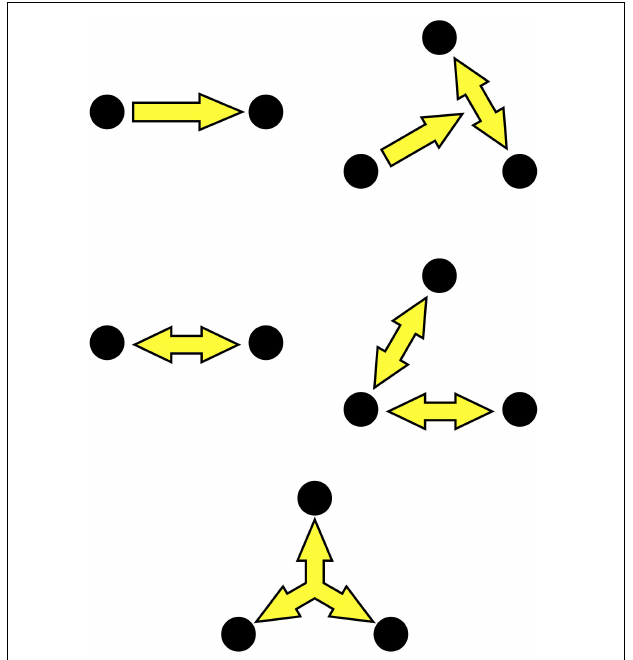
FIGURE 1 | Three hypothesized levels of SMCs in social interaction: (Top) Check SMCs may be mediated by unidirectional coupling between two agents (left) or from one person to other interacting agents (right). (Middle) Sync SMCs involve reciprocal coupling between two or more agents. (Bottom) Unite SMCs are conceived as emergent higher-order correlation patterns in the group dynamics.